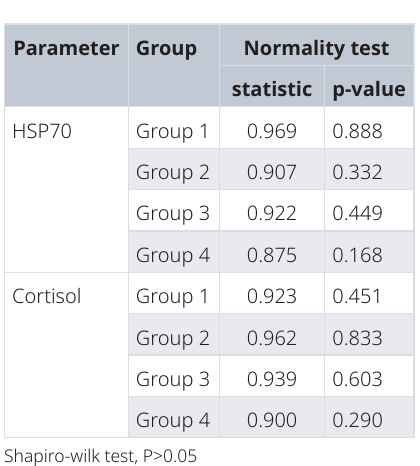
Table 1. Normality test for heat shock protein 70 (HSP70) and cortisol